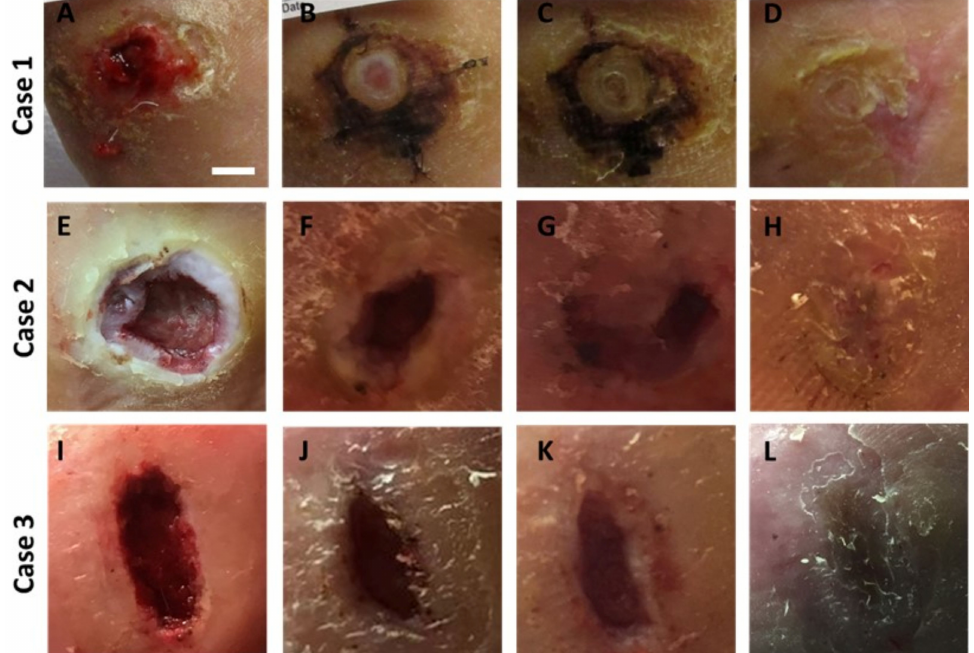
Figure 4. Representative images of progressive healing following treatment with the synthetic hybrid- scale fiber matrix. Case 1 diabetic foot ulcer at ( A ) week 0, ( B ) week 2, ( C ) week 4, and ( D ) complete healing at week 6. The scale bar represents 1 cm. Case 2 diabetic foot ulcer at ( E ) week 0, ( F ) week 5, ( G ) week 8, and ( H ) complete healing at week 12. Case 3 diabetic foot ulcer at ( I ) week 0, ( J ) week 1, ( K ) week 2, and ( L ) complete healing at week 4.